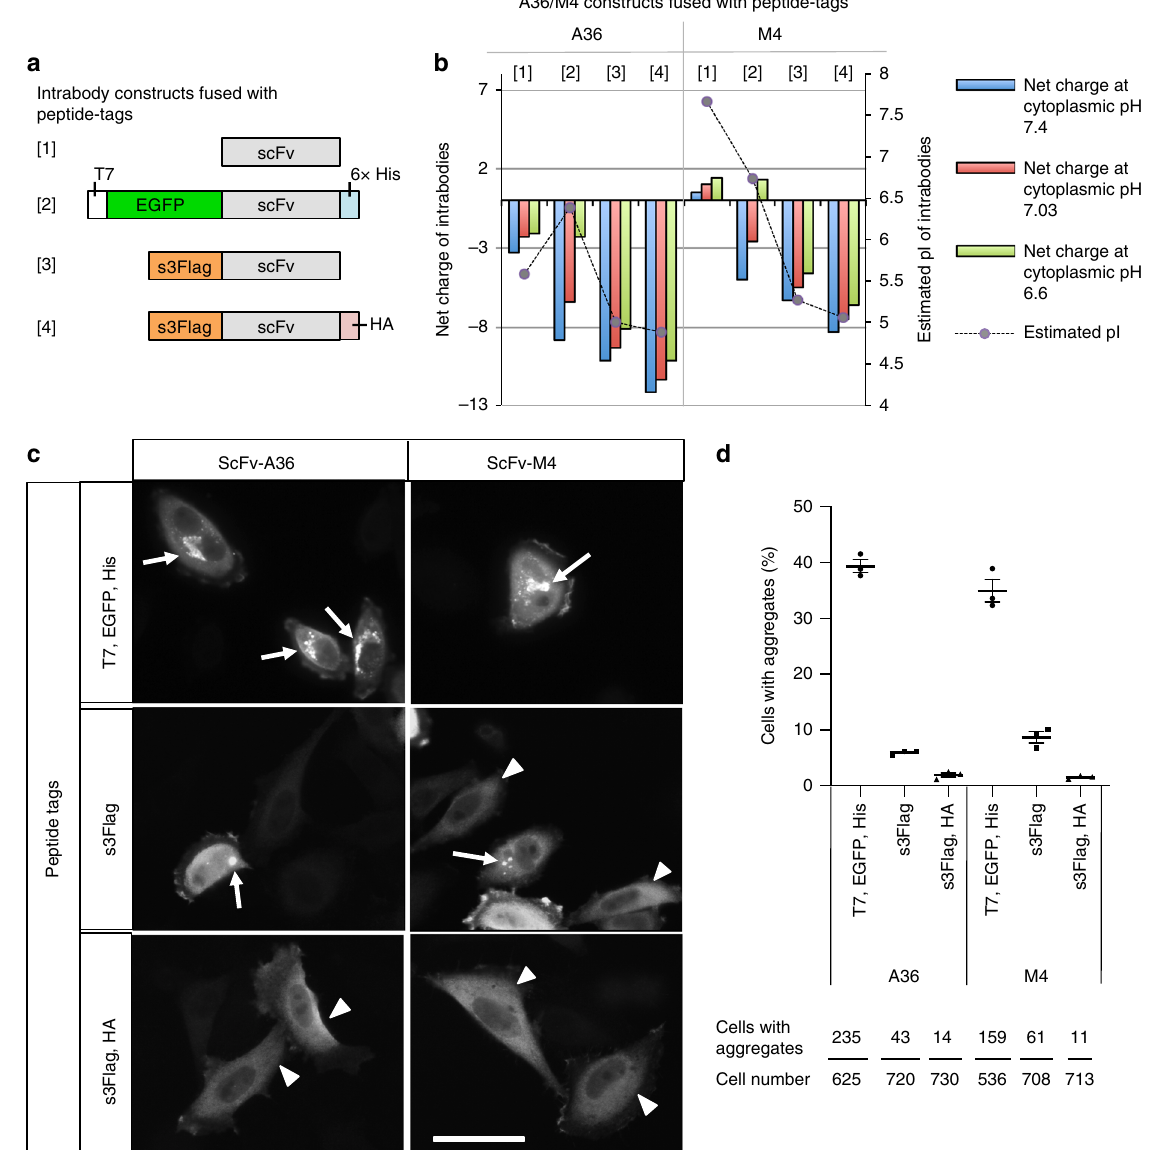
Fig. 1 Engineering ultra-stable cytoplasmic antibodies (STANDs). a Schematic representation of scFv constructs fused with various peptide tags: [1] non- tagged scFv, [2] scFv with N-terminal T7 and EGFP, and C-terminal 6× His (scFv-GFP), [3] scFv with N-terminal s3Flag (s3Flag-scFv), [4] ScFv with N- terminal s3Flag and C-terminal HA (s3Flag-scFv-HA). b Net charge comparison of scFv-A36 and scFv-M4 proteins fused with indicated peptide tags at cytoplasmic pH 6.6 (green), 7.03 (red), and 7.4 (blue), and the isoelectric point (pI) determination (grey circle) using in silico physicochemical analysis. c Intracellular stability comparison of scFv-A36 (left panels) and scFv-M4 (right panels) fused with different peptide tags expressed in HeLa cells using immunocytochemistry; anti-Flag (lower and middle panels) or anti-T7 (upper panels) antibodies were used to detect scFv proteins. Arrows indicate intracellular scFv aggregates. Arrowheads indicate scFvs stably expressed in the cytoplasm. Scale bar, 50 μ m. d Percentage of scFv-expressing cells with aggregates in c (upper panel) and total cell and aggregated cell number in 3 independent experiments (bottom panel). Statistical analysis: two-tailed one- way analysis of variance (A36; percentage of aggregation, F (2, 6) = 834.25, P < 0.00001; Tukey ’ s multiple comparison test, s3Flag-A36-HA vs. s3Flag- A36: P = 0.01614, s3Flag-A36-HA vs. scFv-GFPA36: P < 0.00001, s3Flag-A36 vs. scFv-GFPA36: P < 0.00001; M4; percentage of aggregation, F (2, 6) = 180.65, P < 0.00001; Tukey ’ s multiple comparison test, s3Flag-M4-HA vs. s3Flag-M4: P = 0.01949, s3Flag-M4-HA vs. scFv-GFPM4: P < 0.00001, s3Flag- M4 vs. scFv-GFPM4: P < 0.00001). Error bars represent standard error of the mean. Source data are provided as a Source Data fi